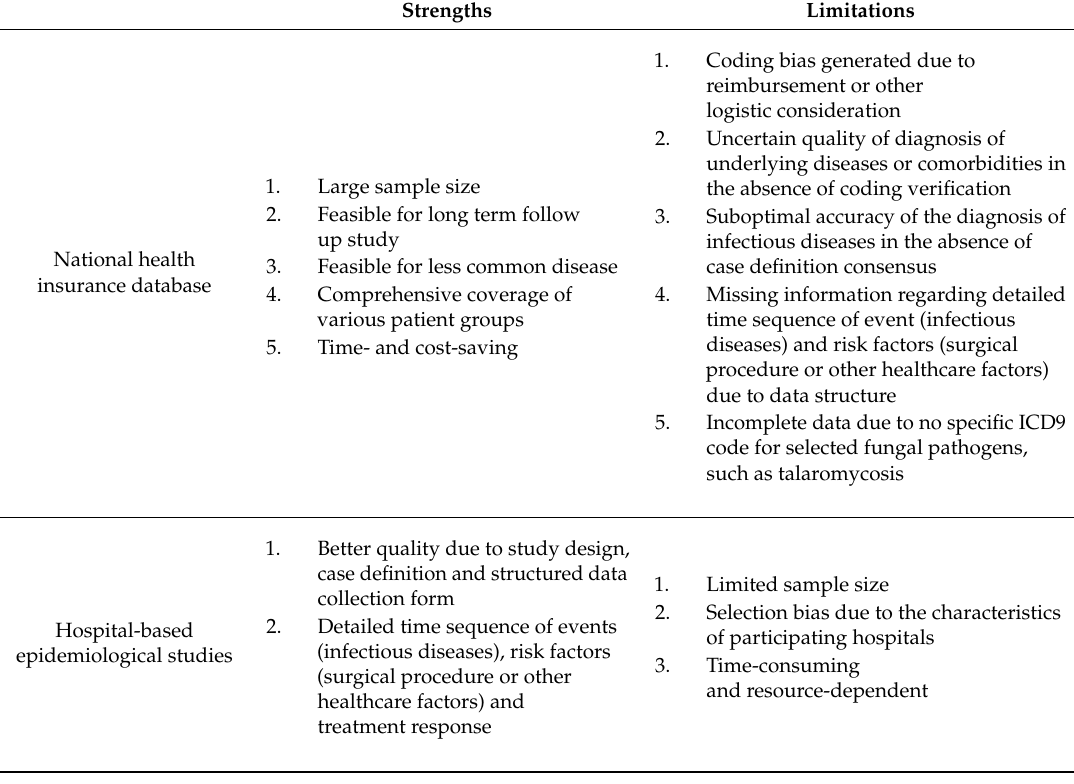
Table 2. Strengths and limitations of using health Insurance database and published hospital-based epidemiological studies for estimation of national burdens of infectious